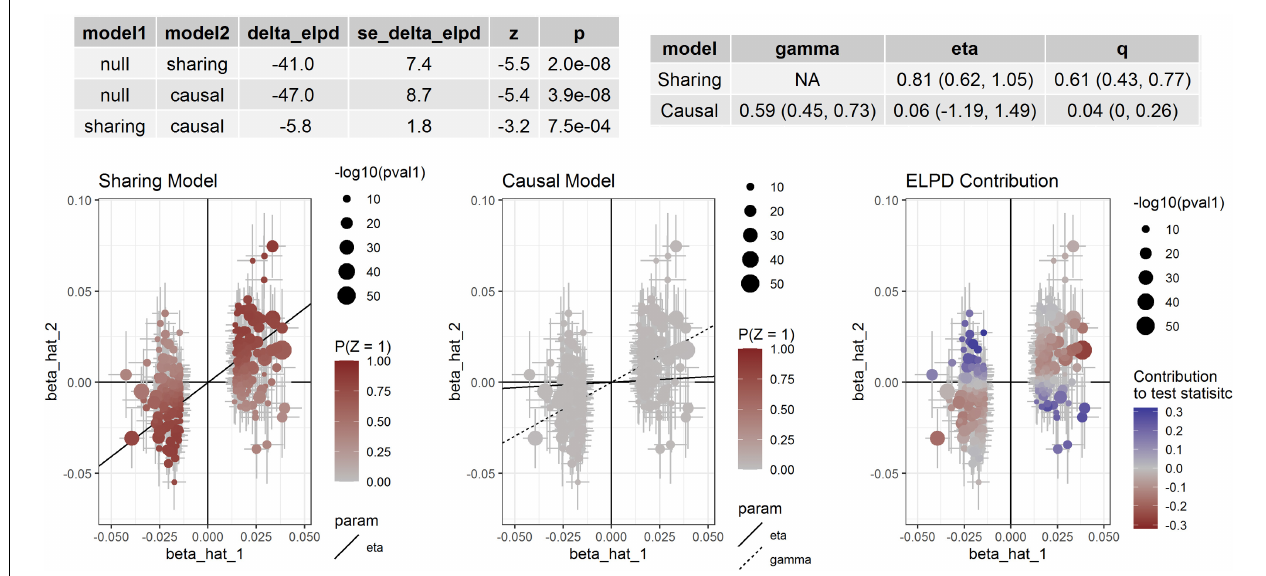
FIGURE 3 | Association between DBP and AA diameter. Effect-size estimates and variant-level contribution to CAUSE test statistics for DBP and AA